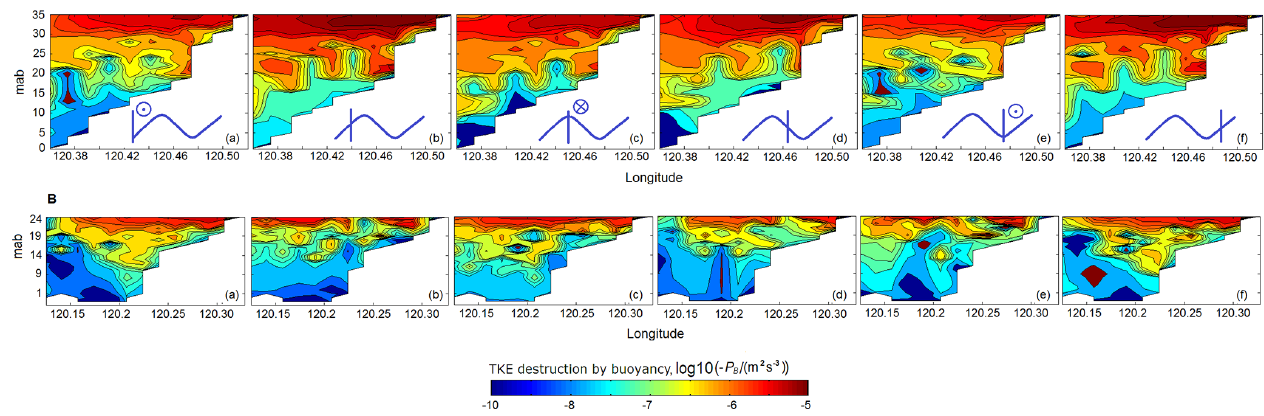
Figure 9. Modelled time–depth variability of TKE at Site 1 (Wu River area) and Site 2 (Zhuoshui River area). The ordinate axis is height (in metres) above the bottom (mab). Ocean surface elevation is depicted by black line. For clarity, TKE results are presented in the absence